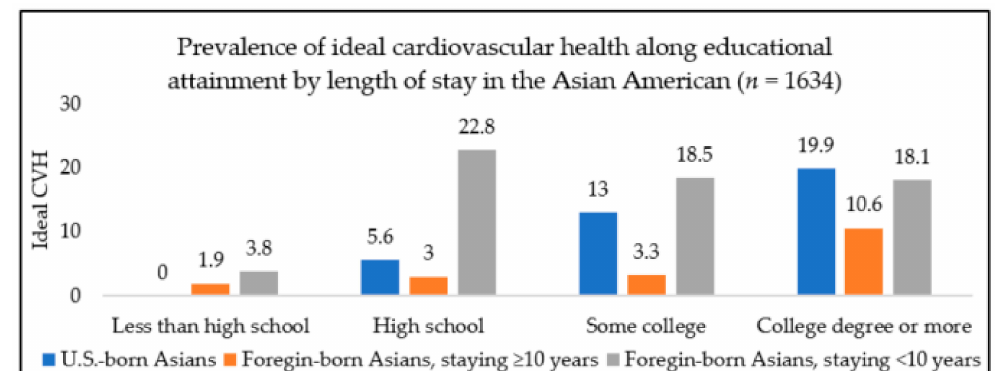
Figure 1. Prevalence of ideal cardiovascular health by education and length of stay among Asian Americans, NHANES (National Health and Nutrition Examination Survey) 2011–2016. CVH, cardiovascular health. Note: No U.S.-born Asian American participant with less than a high school education had ideal cardiovascular health.